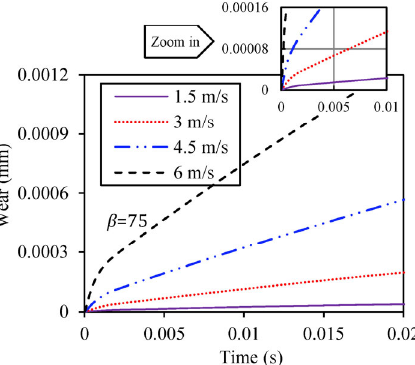
Fig. 15 Magnification of the erosion graphs for the initial transient conditions.